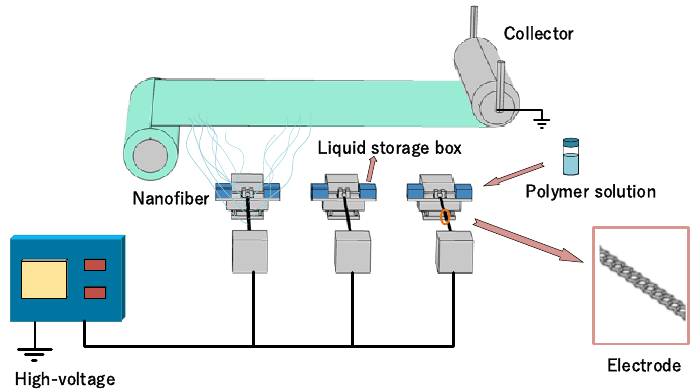
Figure 1. Schematic of electrode sputtering electrospinning device.